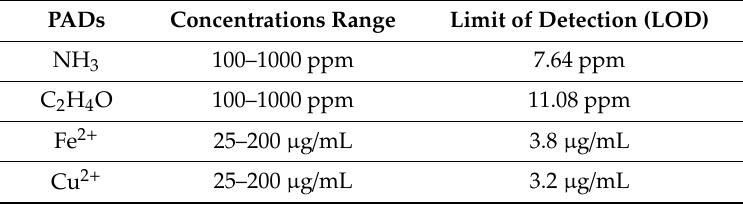
Table 1. LOD values of NH 3 , C 2 H 4 O, Fe 2 + and Cu 2 +